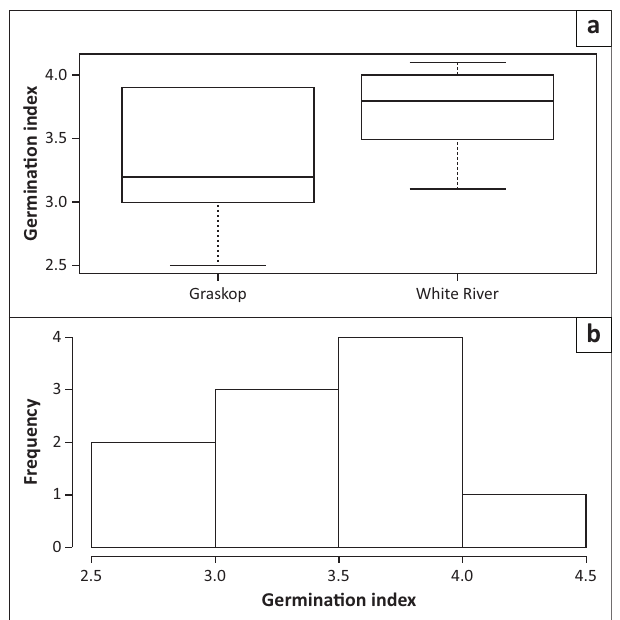
FIGURE 9: (a) Boxplots showing germination indices of Graskop and White River seeds. (b) Histogram showing the range of germination indices recorded in the 10 replicate samples (both White River and Graskop are included here as there was no difference between sites).